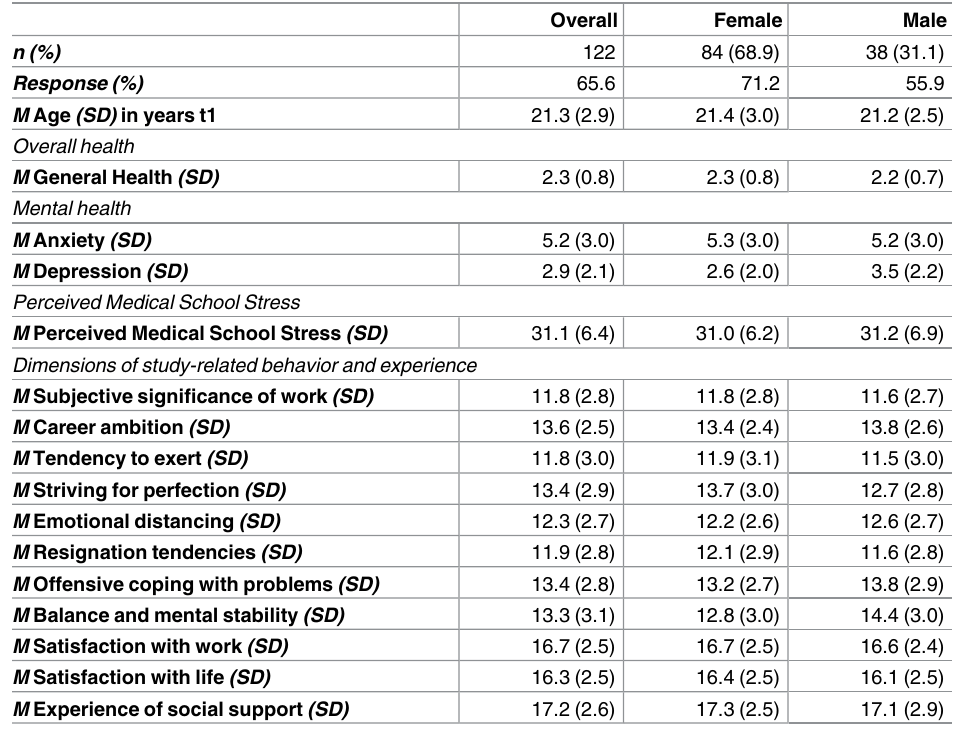
Table 1. Baseline (t1)